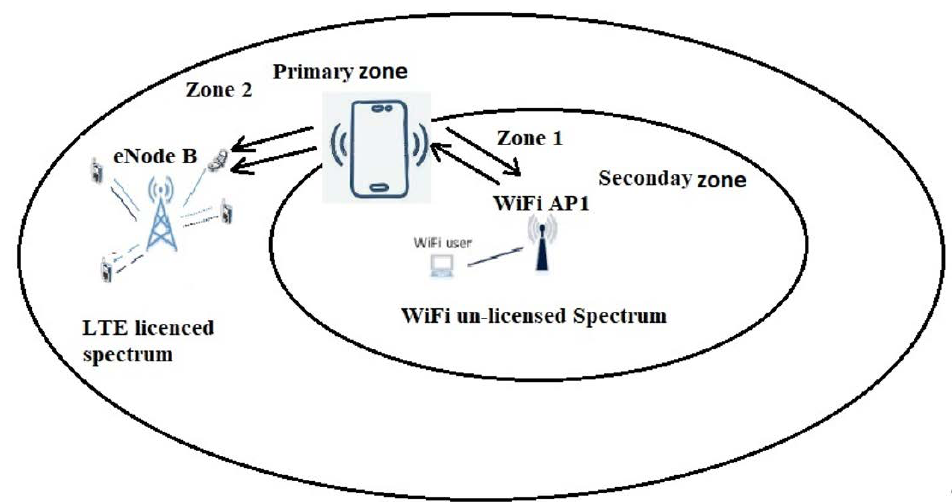
Figure 1. LTE/Wi-Fi integration/coexistence